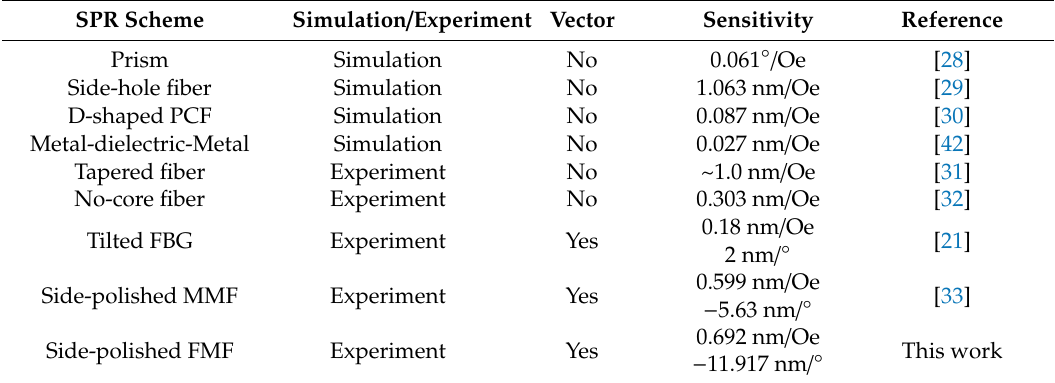
Table 1. Comparisons between the smartphone-based and the traditional platforms.